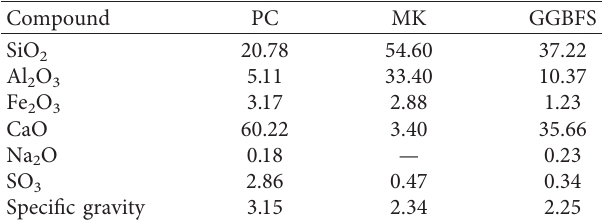
Table 1: Chemical composition of binders.